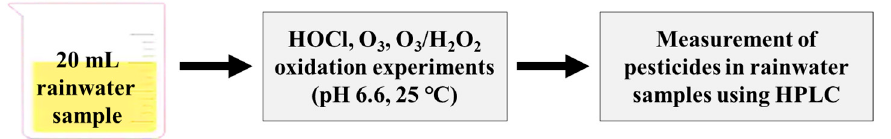
Figure 1. The diagram for batch-scale oxidation experiments for pesticides in rainwater samples.